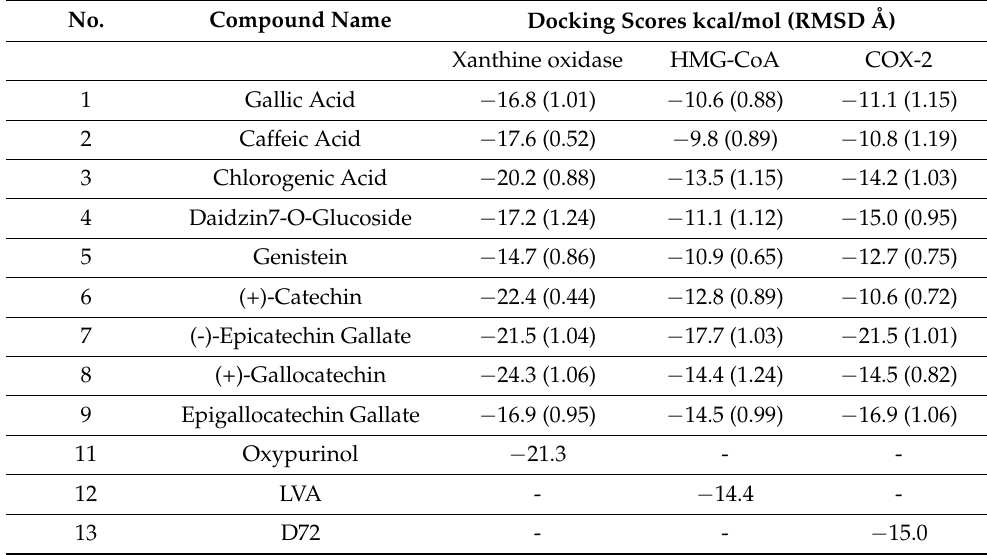
Table 3. Binding energies (kcal/mol) obtained after